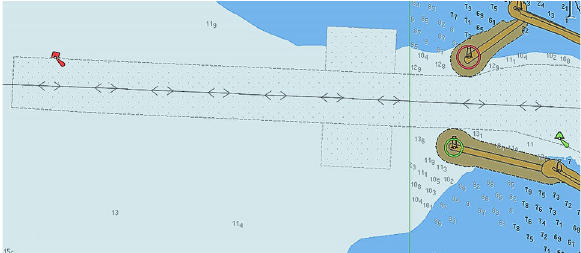
Figure 2. The approach channel to the Port of Klaipėda (150 m in width)